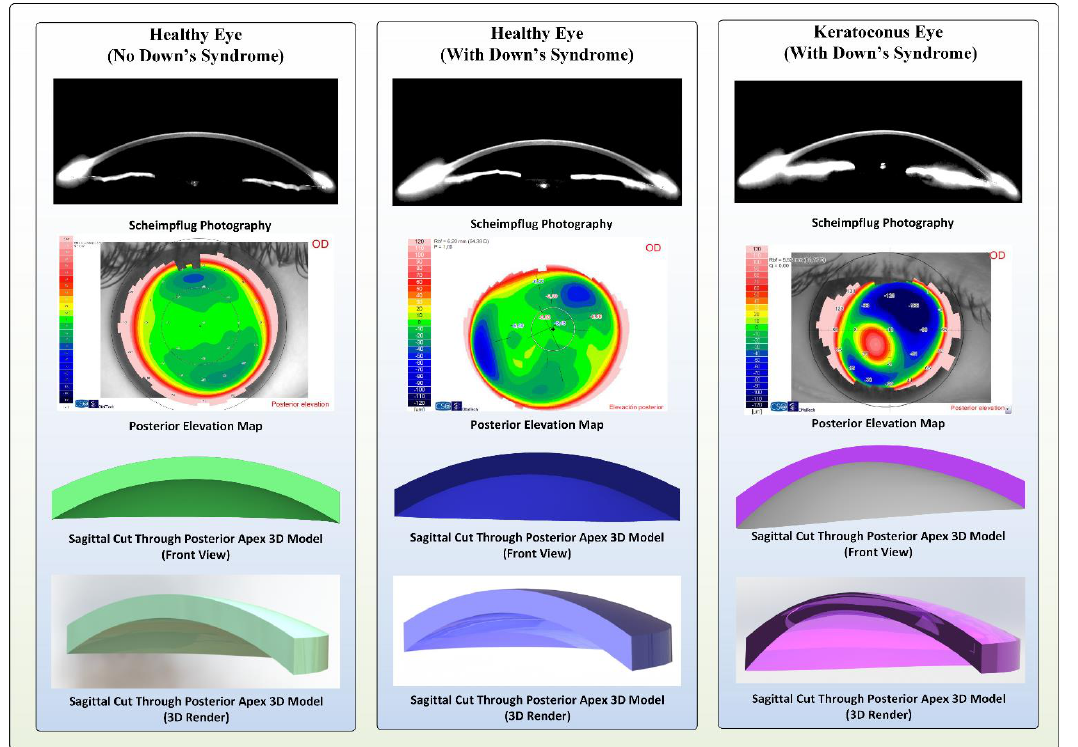
Figure 2. Topographical and three-dimensional (3D model) images of the cornea for sample cases in the control, Down syndrome (DS) with normal topography and DS with abnormal topography groups.